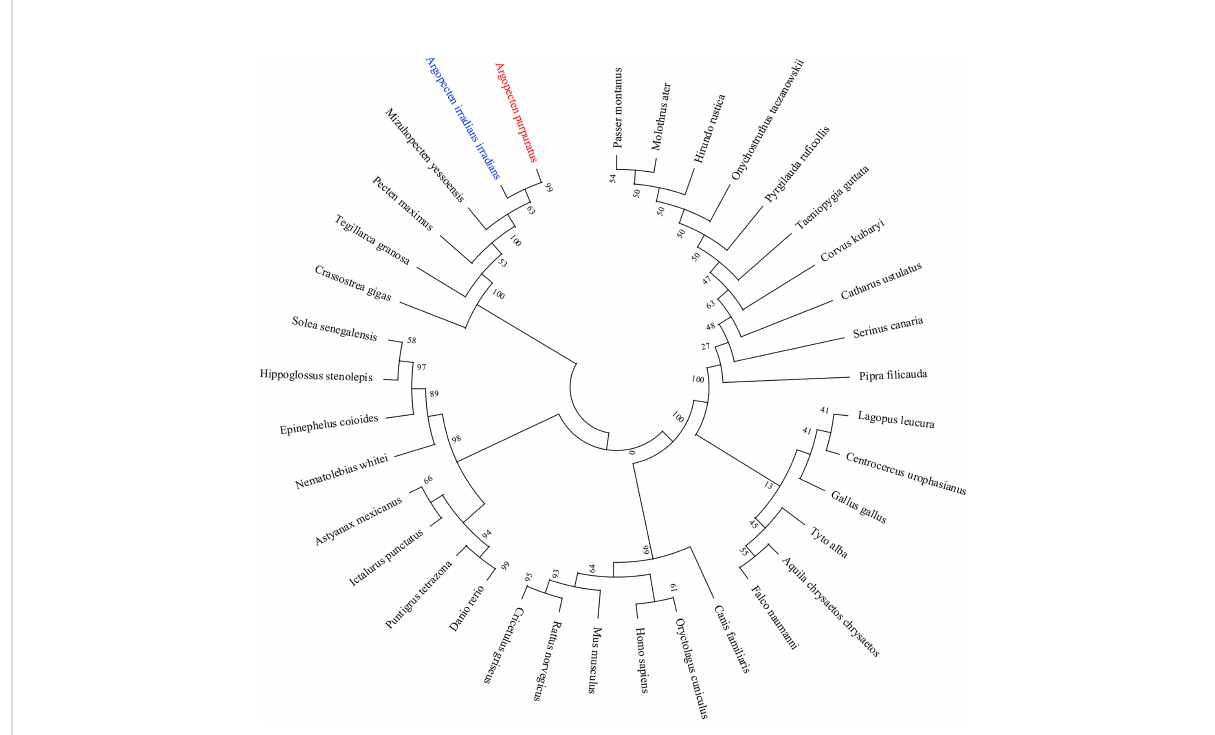
FIGURE 6 NJ phylogenetic analysis of AiiMEK1 and ApuMEK1 with other species.